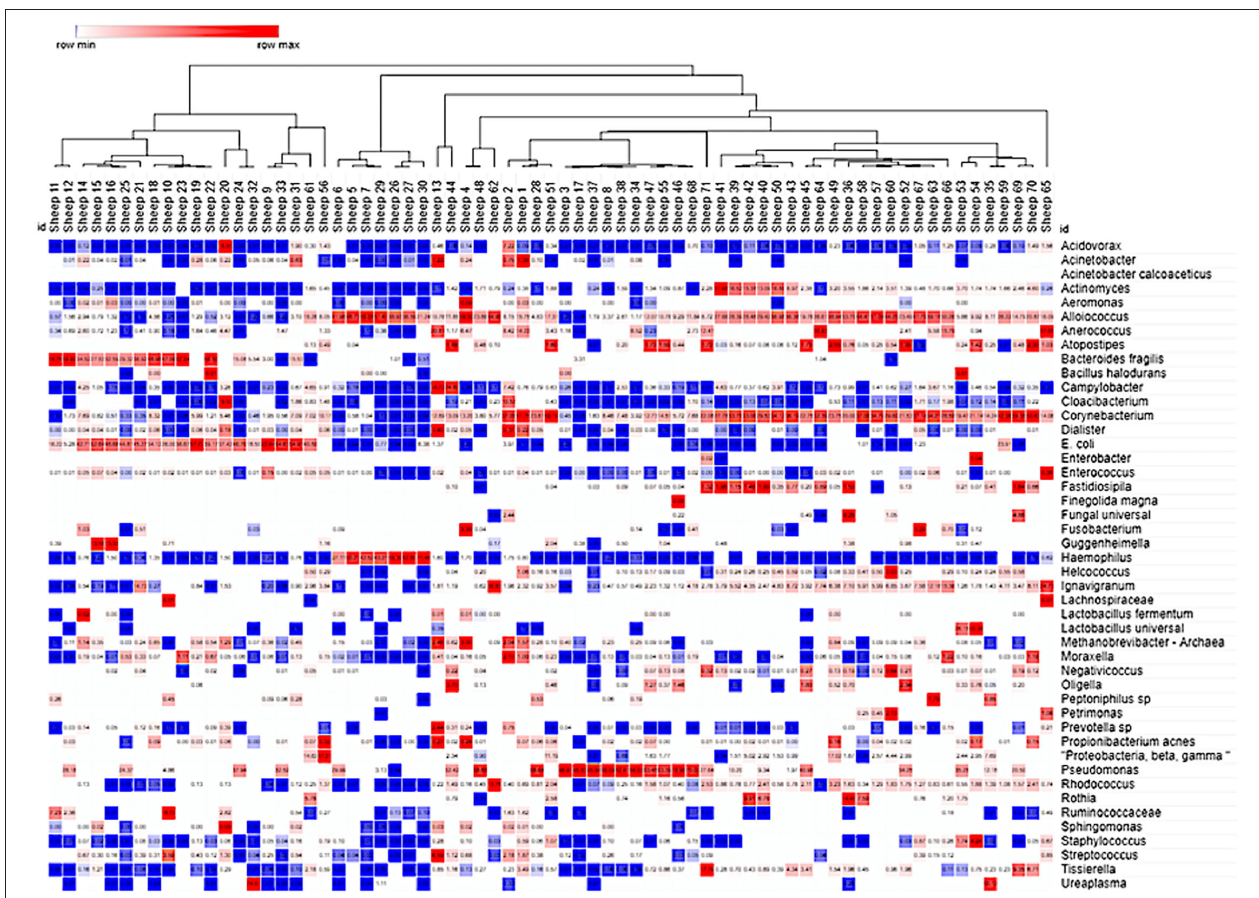
FIGURE 4 | Cluster analysis of the ovine VMB in naïve and Sham-treated animal samples. Heat map clustering [unsupervised using Morpheus online (43)] illustrated dominance by individual or combinations of bacteria as well as grouping of samples into community type (CT) categories indicated by branching shown across the top of the Figure. Proportional levels of the bacteria (right vertical labels) quantified by the VMBA are shown in rows with each sample ( n = 71 distinct sheep) shown as a distinct column. Red boxes represent the maximal levels detected in a row, and blue shows the lowest detection levels. Clustering helped to identify CTs that were dominated by biomarker organisms that were confirmed by statistical comparisons, leading to the categorical CT system shown in Figure 5